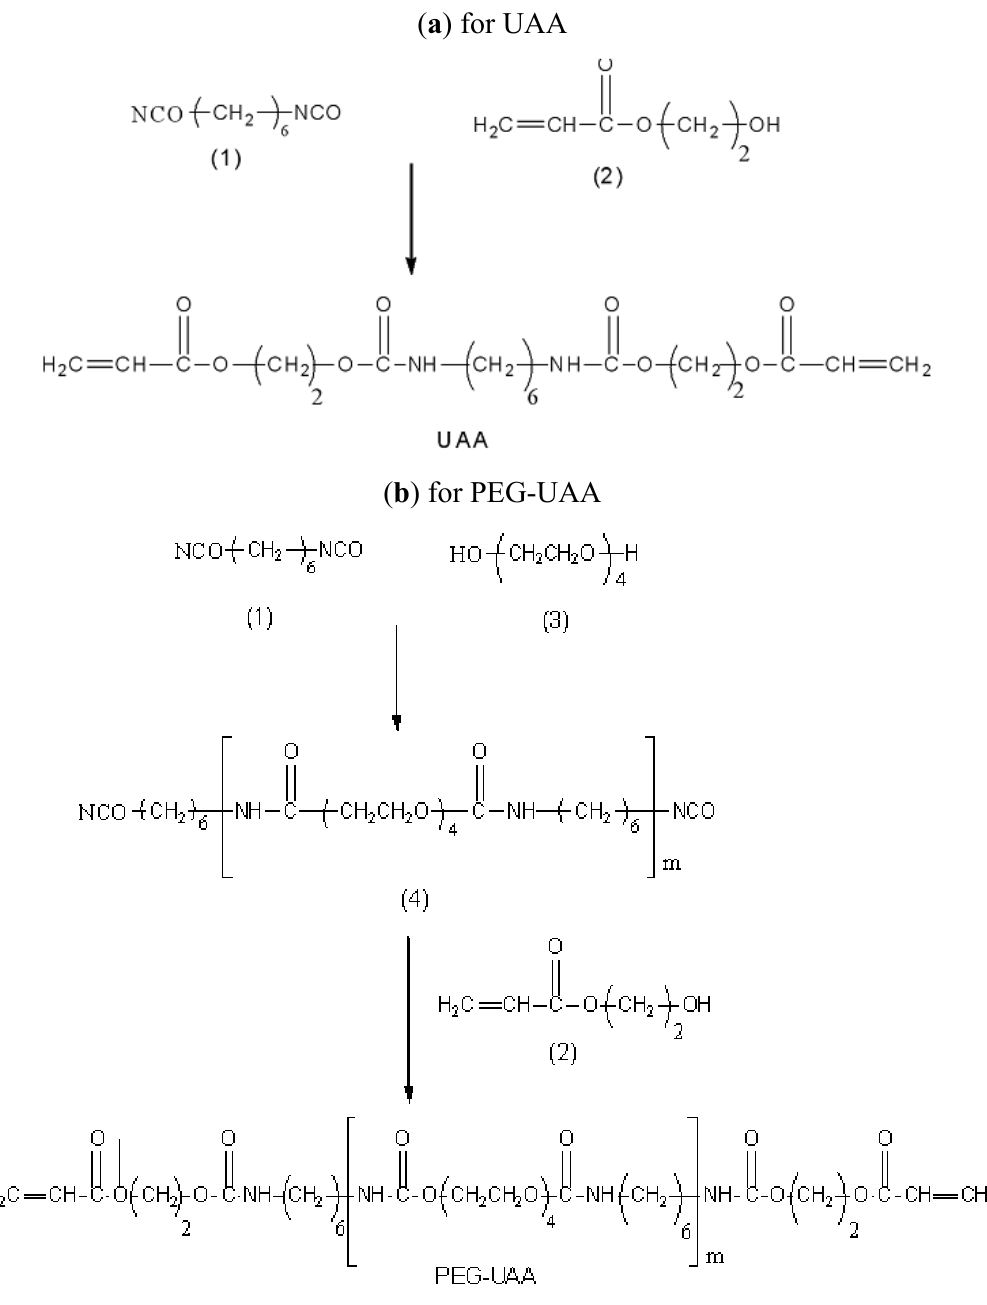
A mold with a hollow spacer (0.3 mm in depth) on a bottom lining (polypropylene) was set on a glass plate and then the solution was cast into the mold. After the polypropylene lining cover was placed over the mold, another glass plate was placed and the whole assembly was fixed by clips. An UV-lamp was applied for photo-polymerization during 60 s. After polymerization, the polymer and polymer-COC composites were vacuum dried in a